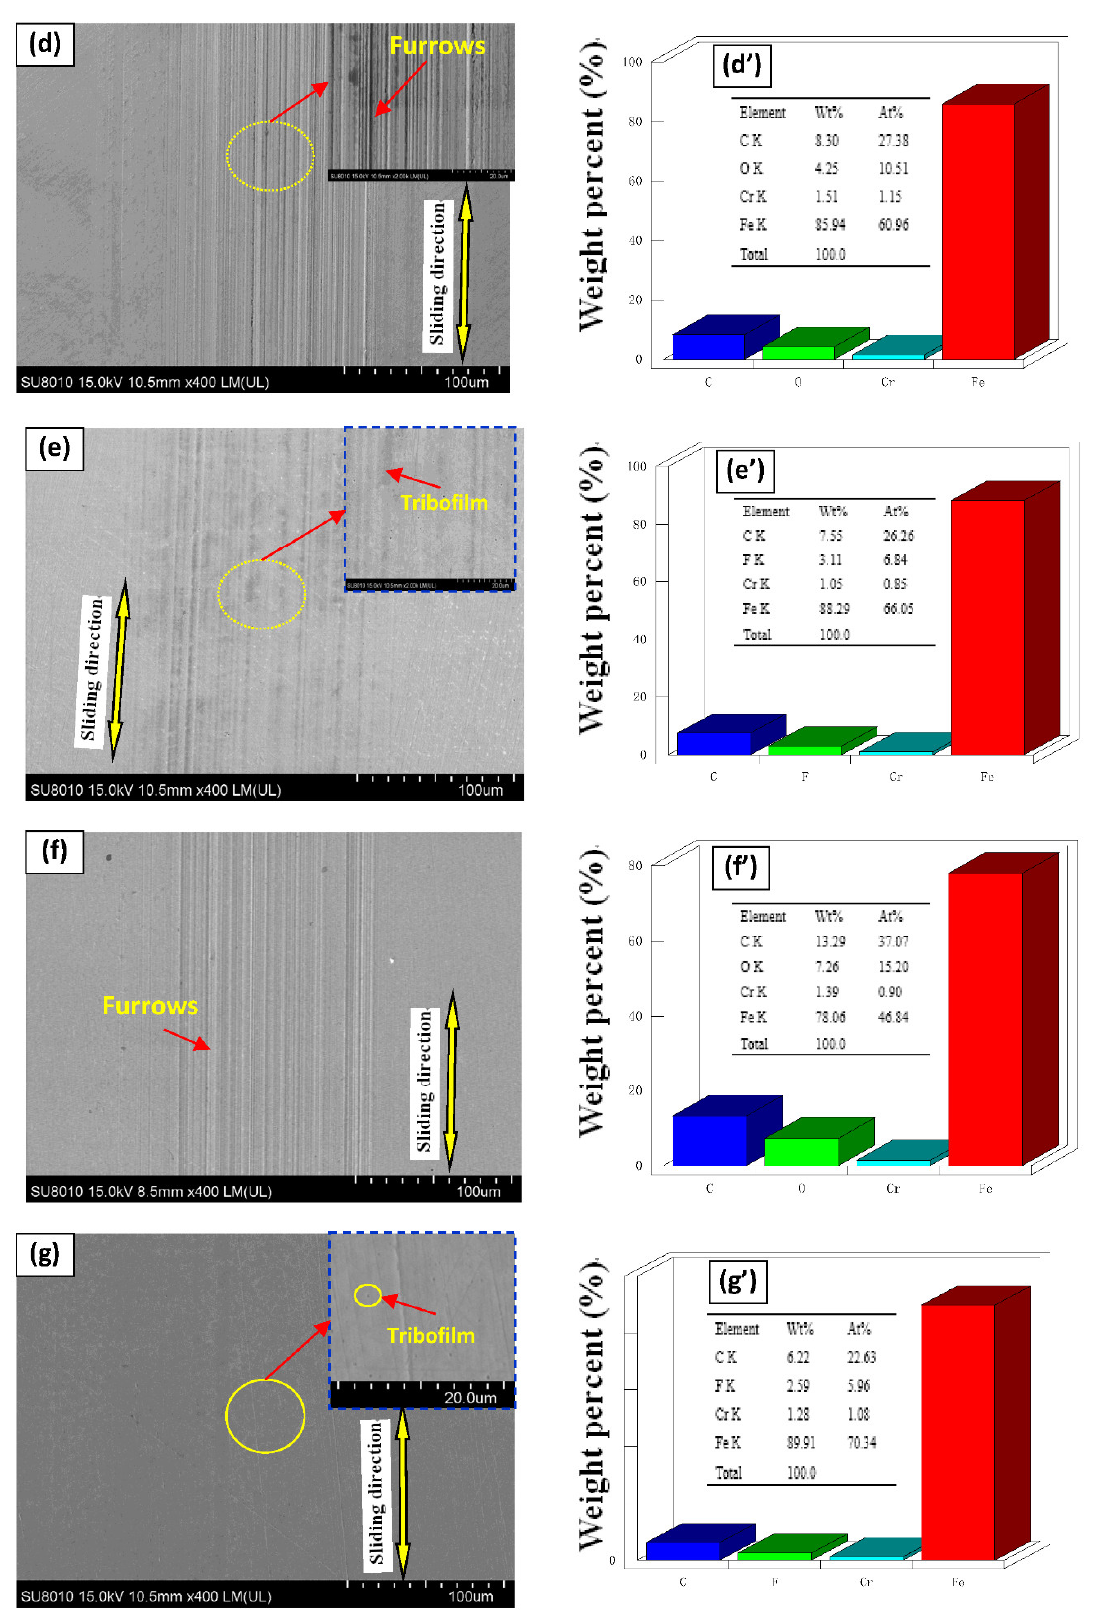
Figure 8. SEM/EDS analysis of steel sheet surface with different content of GR and F-GR added in PAO at 50 N and 10 mm/s for 60 min. ( a ) PAO6, ( b ) 0.1 wt% GR, ( c ) 0.1 wt% F-GR, ( d ) 0.5 wt% GR, ( e ) 0.5 wt% F-GR, ( f ) 1 wt% GR, ( g ) 1 wt% F-GR.